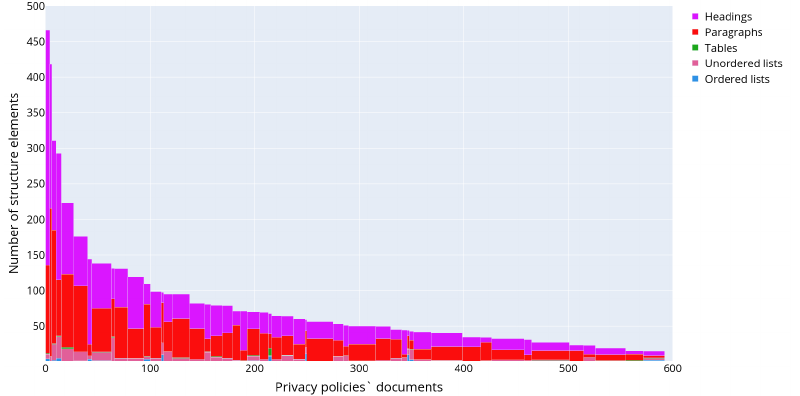
Figure 6. Structure of the privacy policies in corpus “IoT dataset”.